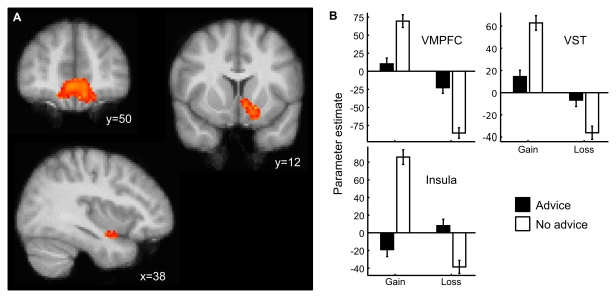
Advice modulated the standard BOLD response to rewards.(A) Regions showing greater BOLD response to positive than to negative feedback after not following advice. Top left: VMPFC (max. z-score = 3.50, x = −4, y = 50, z = −18); top right: Left VST (max z-score  = 3.73, x = −16, y = 12, z = −10); bottom left: Insular cortex (max z-score  = 3.33, x = 38, y = 8, z = −16). (B) Estimated parameter estimates show that following advice led to an attenuation of the standard reward signal (as identified from trials in which participants did not follow advice) in the VMPFC and the VST.